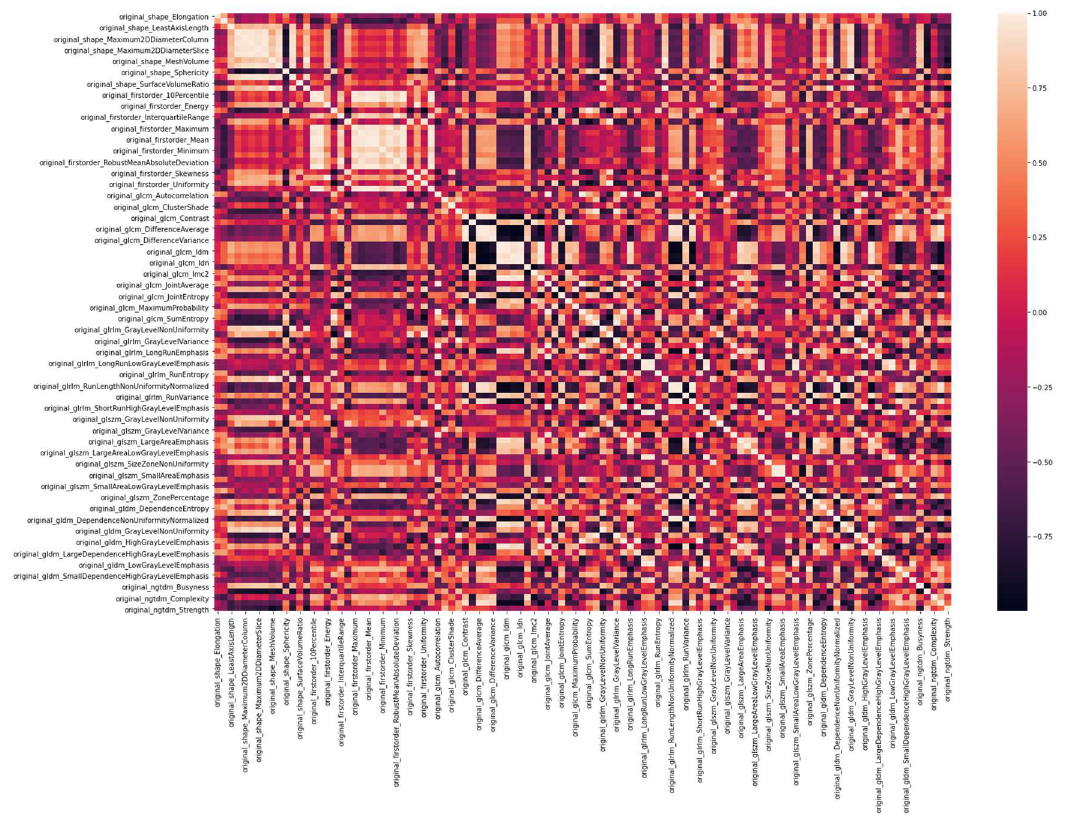
Figure 5. Correlation matrix for the 107 radiomics features.